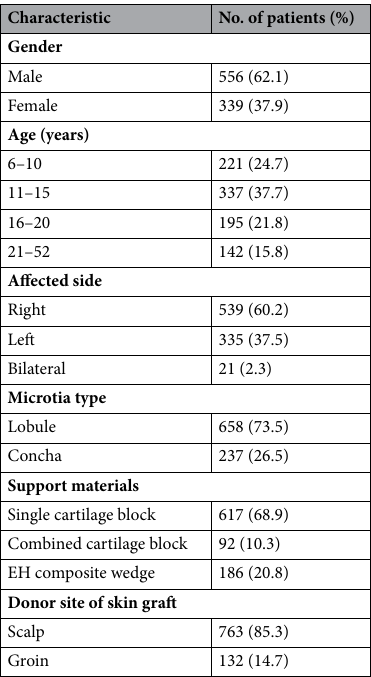
Table 1. Clinical data of the 895 microtia patients